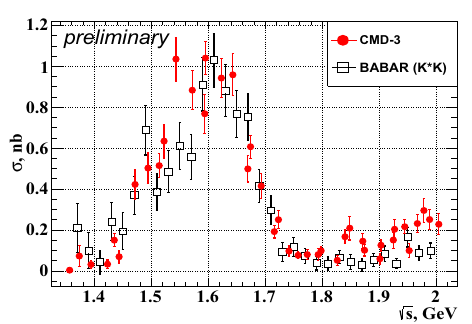
Figure 1. Cross sections of the process e + e − → K + K − π 0 with the BaBar data. CMD-3 results - red dots, BaBar, measured in the η → 2 γ mode are plot- ted by squared markers.